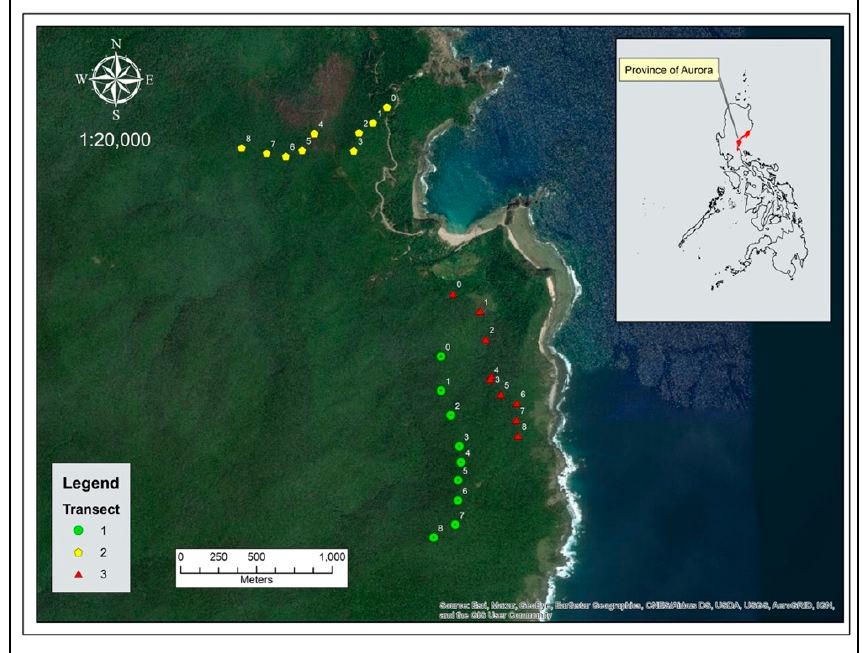
Figure 1. Location map of the study site in Baler, Province of Aurora in the Philippines.